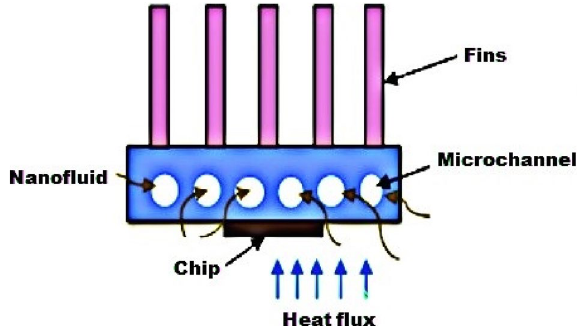
Figure 2. Minichannel heat sink schematic diagram.